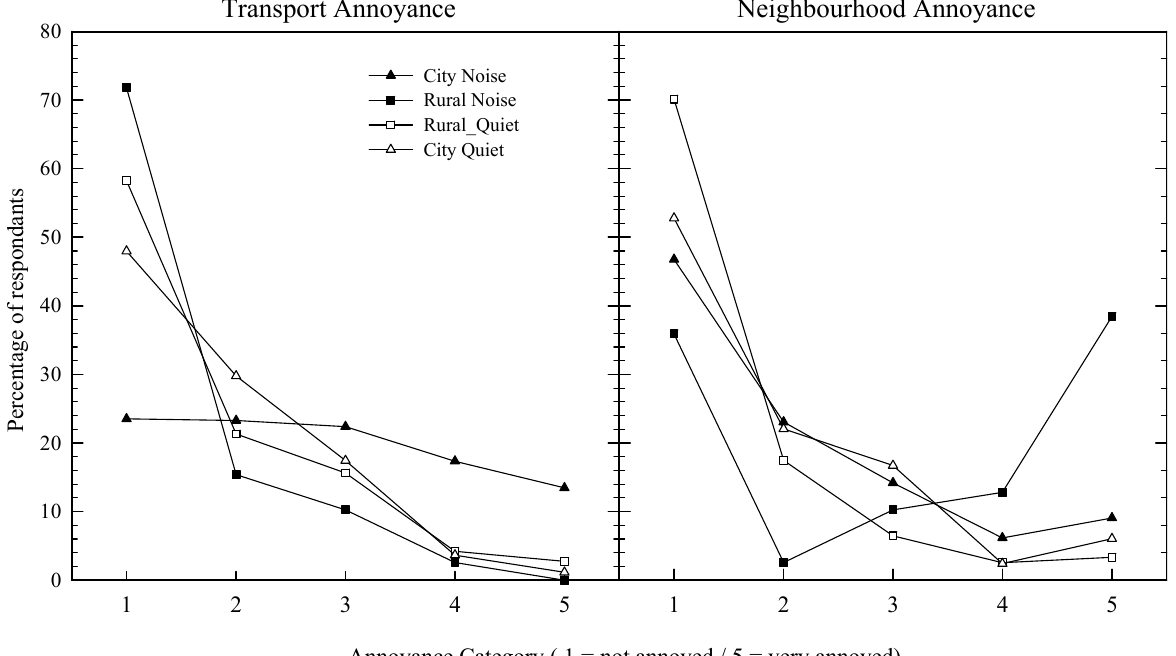
Figure 1. Percentage of respondents indicating annoyance to transportation (left plot) or neighbourhood (right plot) noise, for four different areas (see